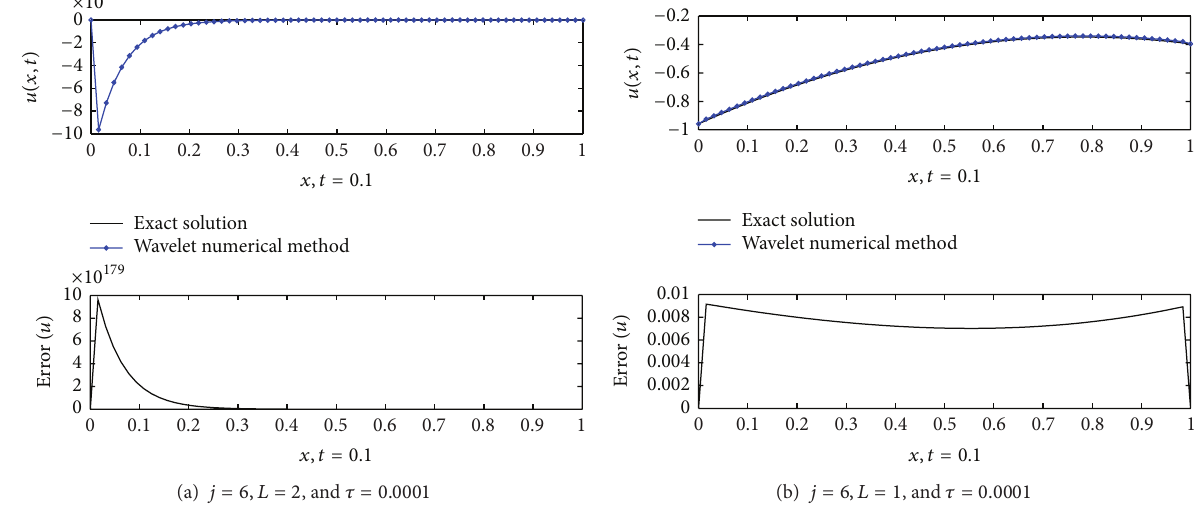
Figure 2: Wavelet collocation method with constant 𝐿 (𝛼 = 0.6)